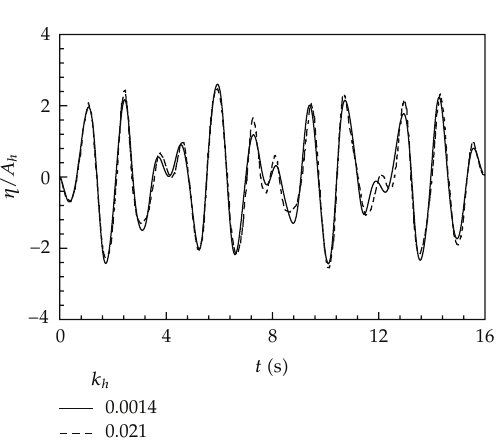
Figure 10: Time histories of wave surface at the left tank wall for k h (cid:8) 0 . 0014 and